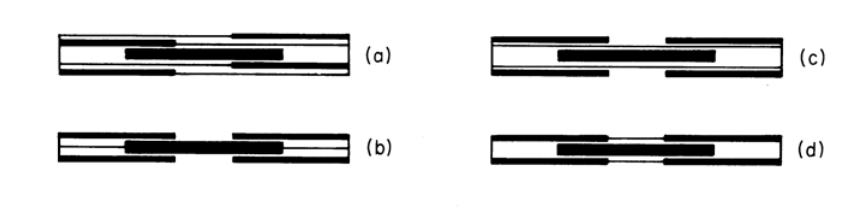
FIGURE 1. Graphical representation of the most probable continuous structures in sarcomere: (a) thin fila- ment–thin filament structure; (b) Z–Z structure; (c) Z–thick filament structure; (d) Z–thin filament